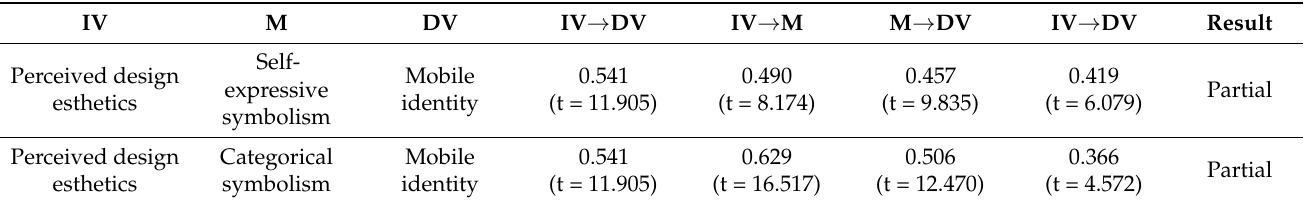
Table 8. Three-step test of mediating